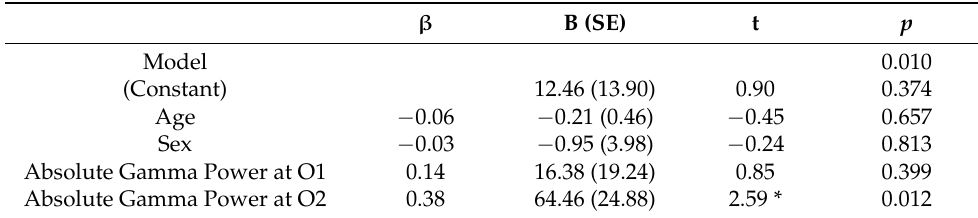
Table 6. Linear regression models of WURS as predicted by the absolute gamma power during the VWM task over the occipital scalp sites in healthy volunteers.